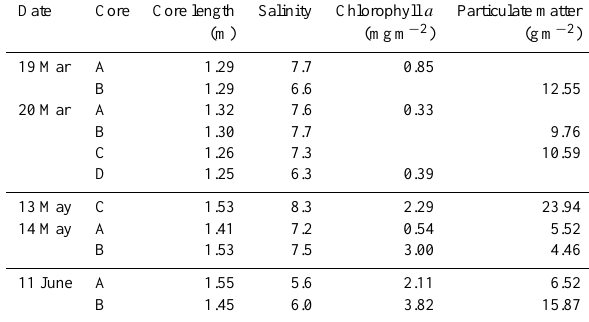
Table 1. Vertically integrated sea-ice properties from all full-length cores obtained during the measurements in 2010. Missing values were not measured. Full profile data are available online